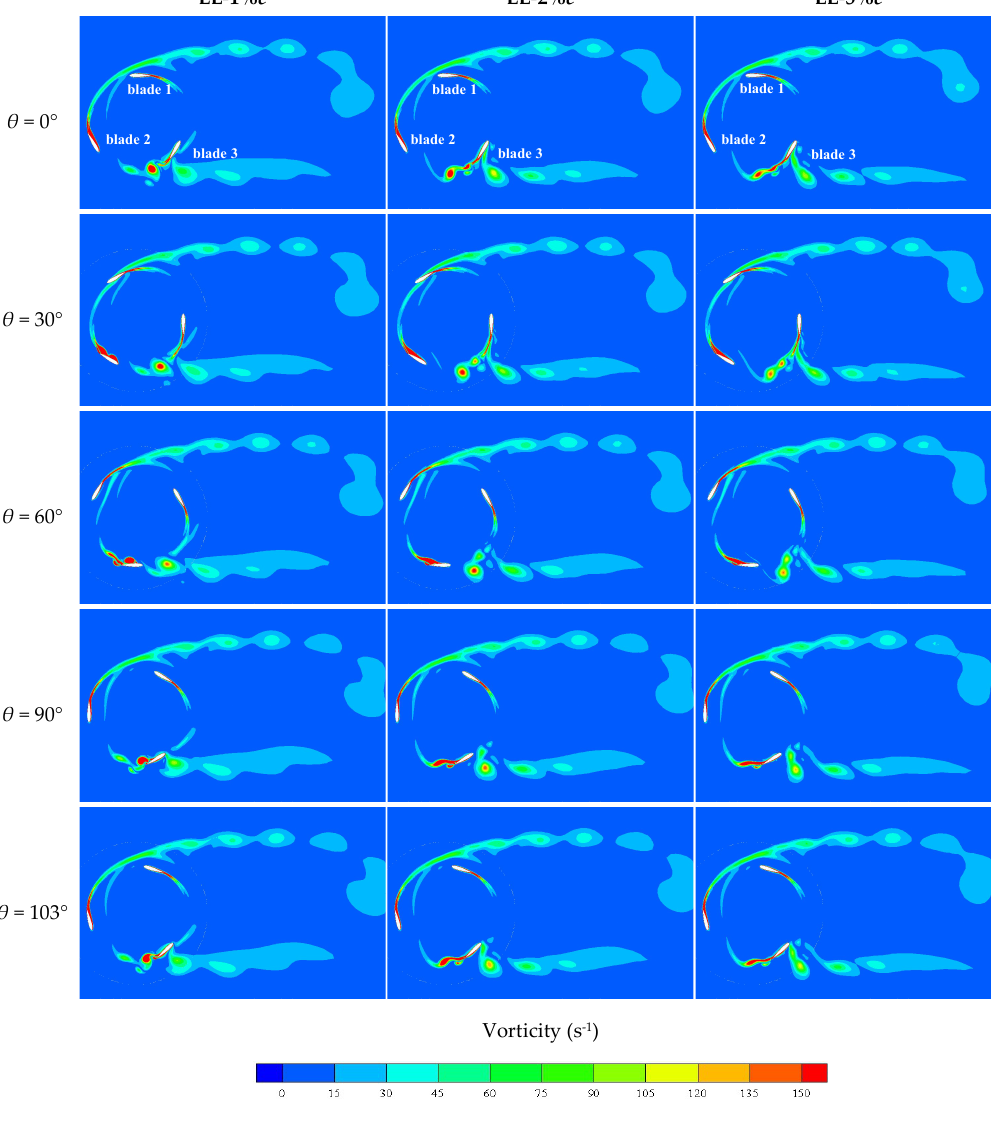
Figure 12. Instantaneous contours of vorticity magnitude around the blades with different airfoil leading edge radius at TSR = 2.0 at azimuth angles of 0°, 30°, 60°, 90°, and 103°.